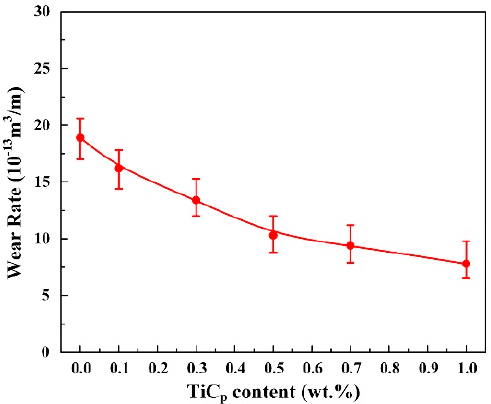
Figure 8. The wear rates of the Al-Cu matrix alloy and nano-sized TiC p /Al-Cu composites reinforced by different contents of nano-sized TiC p under 20 N load at 180 °C.